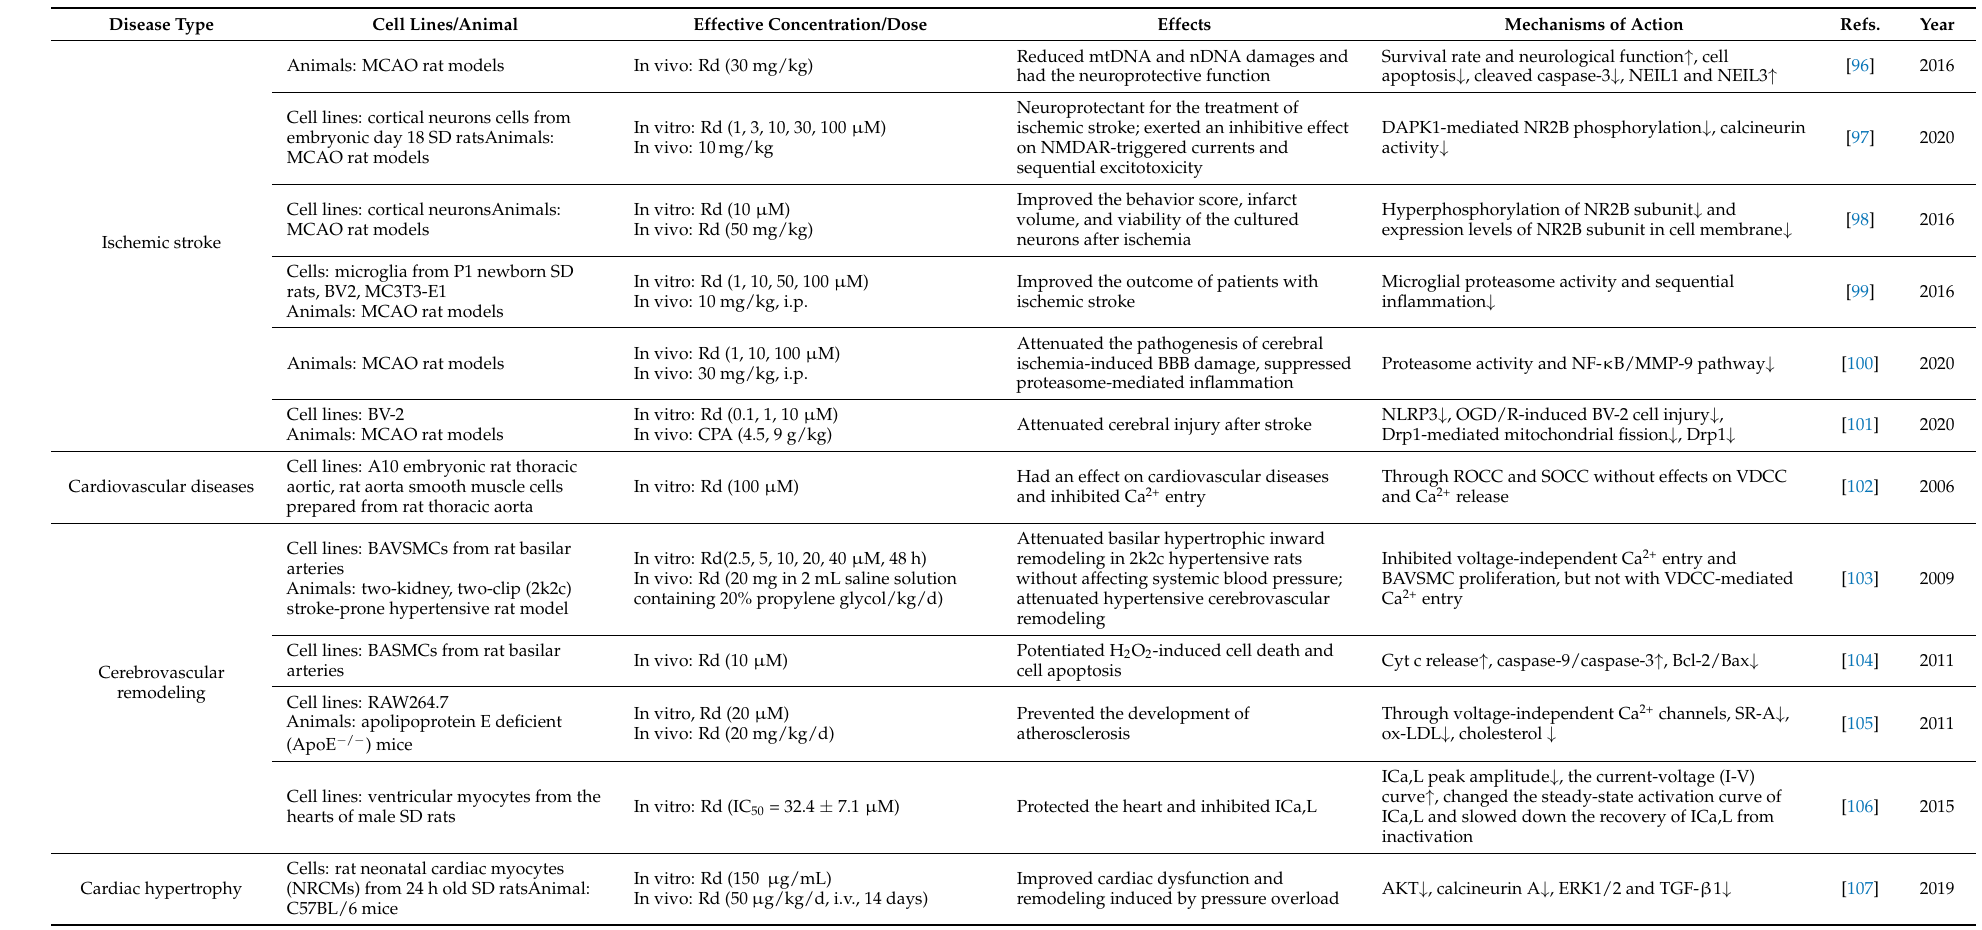
Table 5. Ischemic stroke, cardiovascular protection, and immunological activities and the molecular mechanisms of Rd. Disease